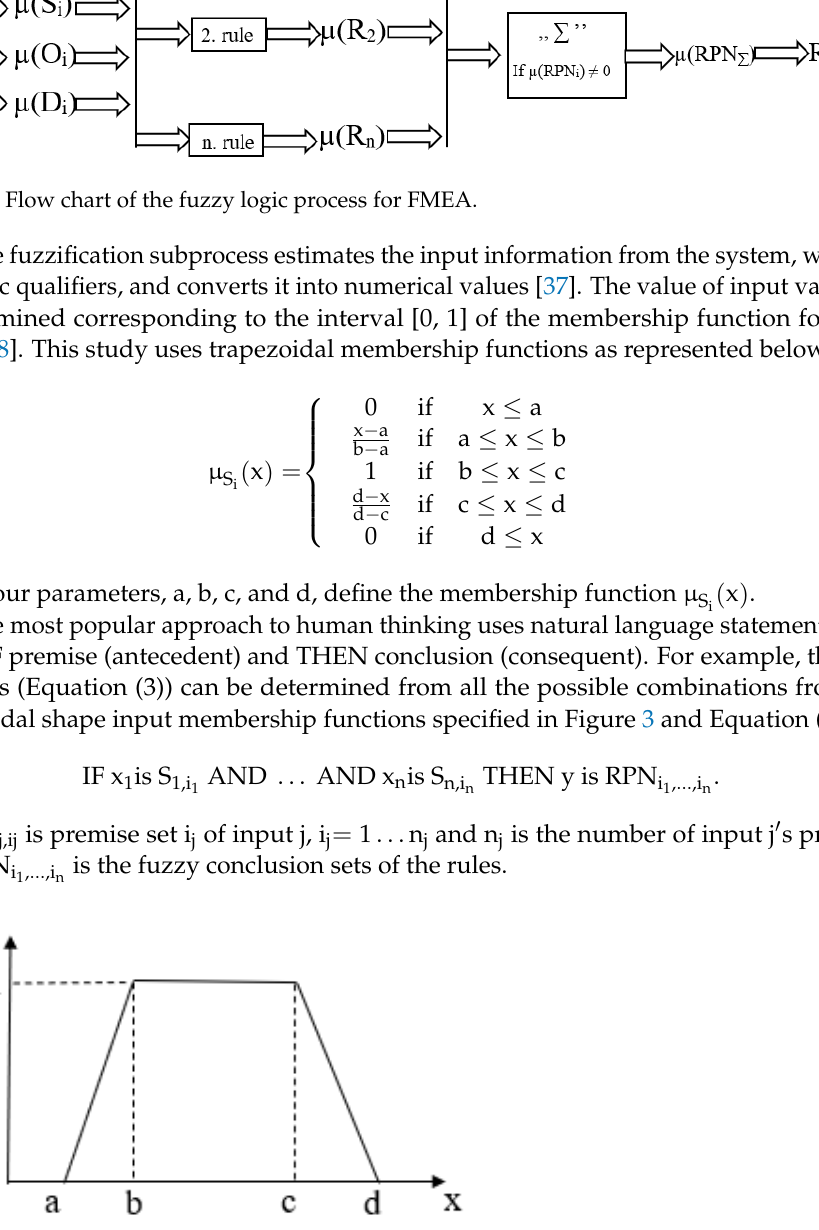
Figure 3. Fuzzification for trapezoidal membership function .